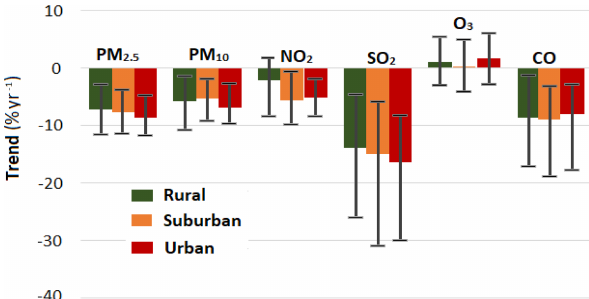
Figure 3. Yearly change of air quality in different areas of Bei- jing. This figure presents yearly average changes of weather nor- malized air pollutant concentrations at rural, suburban, and urban sites (see Figure S1 for classification) of Beijing from 2013 to 2017. Specifically, average yearly changes are for SO 2 ( − 14%, − 15%, and − 16%year − 1 for rural, suburban, and urban areas, re- spectively), CO ( − 9%, − 9%, − 8%year − 1 ), PM 2 . 5 ( − 7%, − 8%, − 9%year − 1 ), PM − 6%, − 5%, − 7%year − 1 ), NO − 2%, 10 ( 2 ( − 1 ). The error − 6%, − 5%year − 1 ), and O 3 (1%, 0.3%, 2%year on the bar shows the minimum and maximum yearly